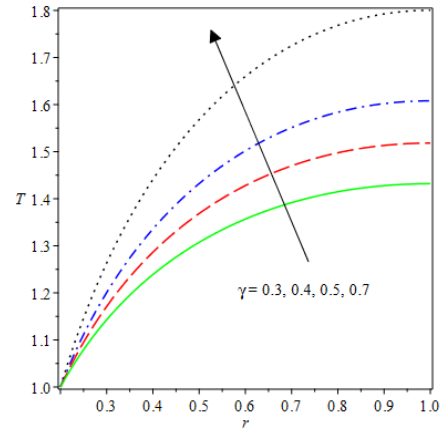
Figure 6. Temperature profile for increasing ( γ )